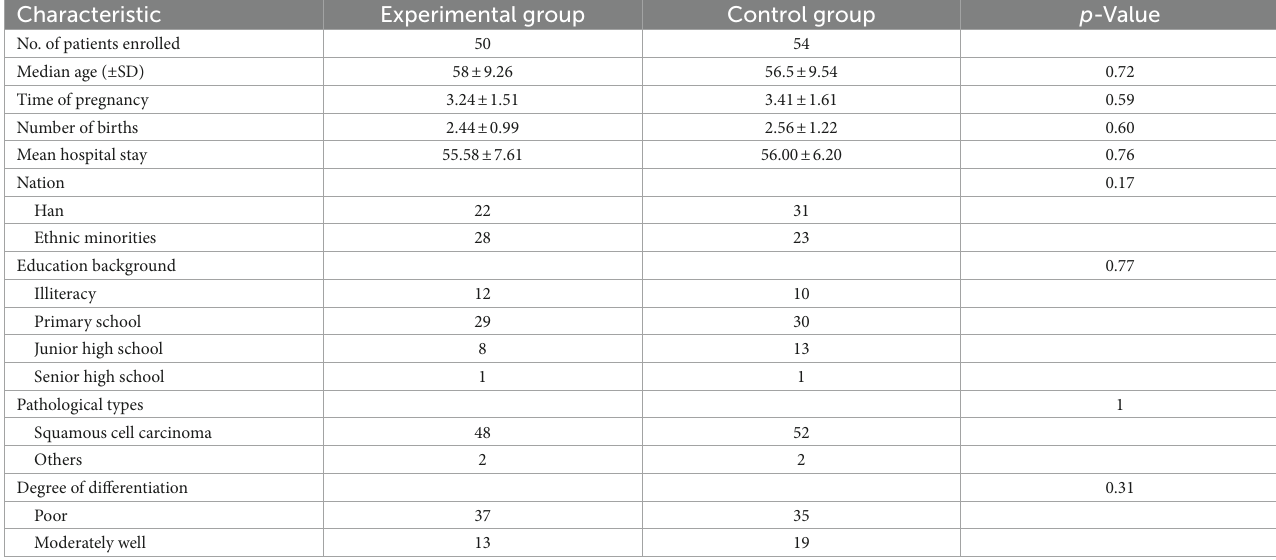
TABLE 1 Baseline demographic and clinical characteristics between the two groups. Characteristic Experimental group Control group p -Value